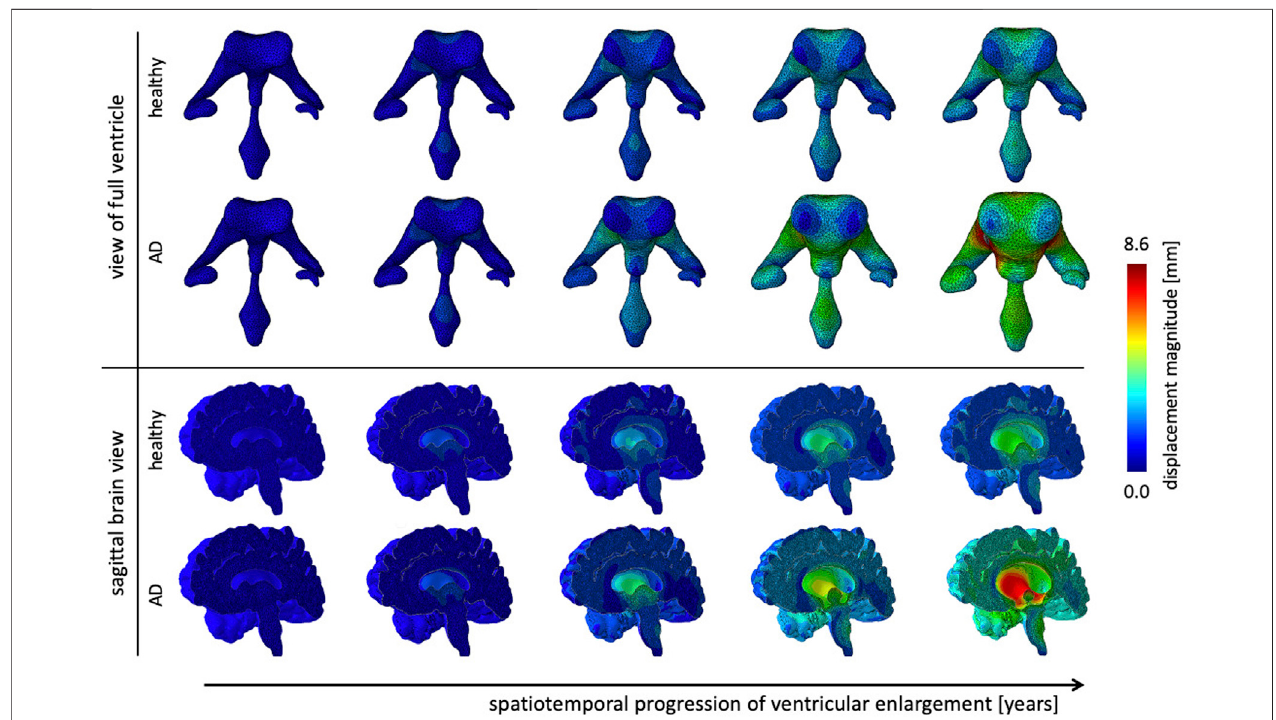
FIGURE 6 | Ventricular enlargement is one of the most prominent features of the aging brain. The ventricular body expands most and the anterior and posterior hornsin fl ateinresponsetotissueloss.Alzheimer ’ sdiseasehasalargeraffectthanhealthyaging.OveralltheventricularvolumemorethandoublesinAlzheimer ’ sdisease and increases by 165% in healthy aging. The sagittal view of the brain shows the effect on deep gray matter structures.